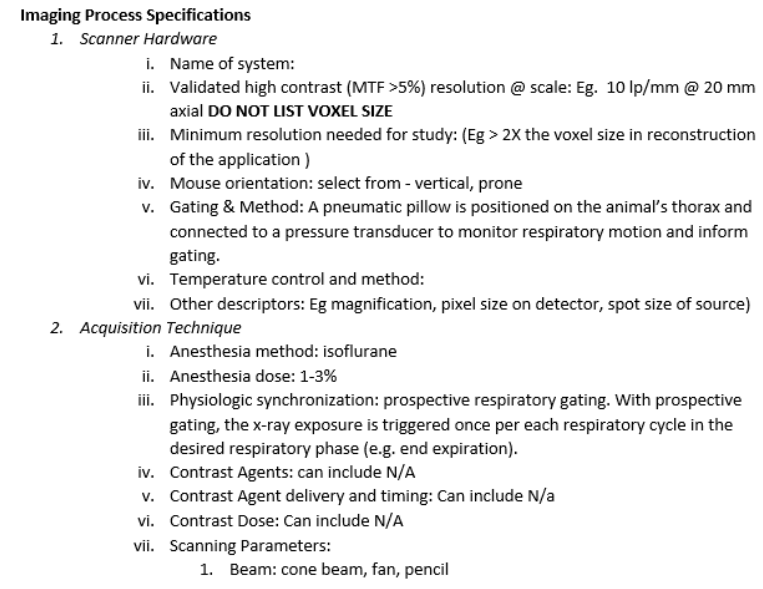
Figure 2. Screen capture of the first page of the pre-clinical imaging template for CT. Blue text indicates commentary, red text indicates instruction.